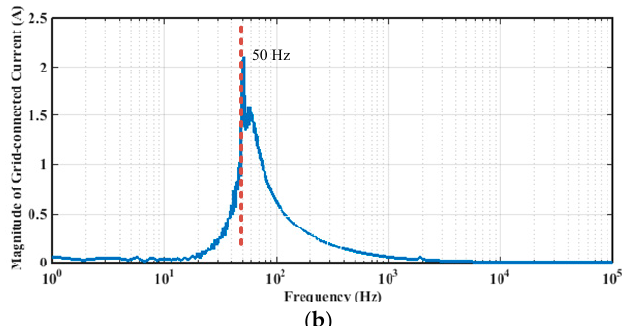
Figure 12. Fast Fourier Transform (FFT) analysis results of the grid-connected current without or with the additional virtual impedance loop: ( a ) without virtual impedance loop; ( b ) with virtual impedance loop.